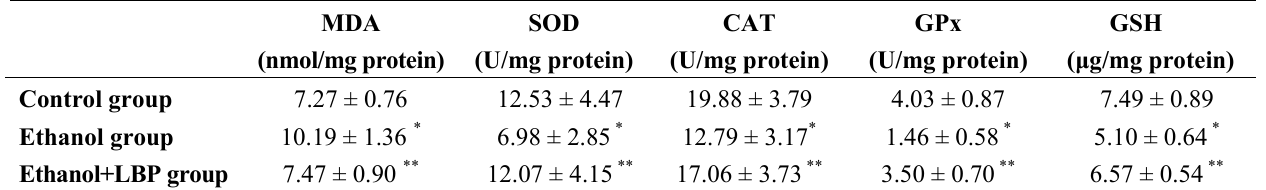
Table 2. Effect of LBP on oxidative stress parameters in rat